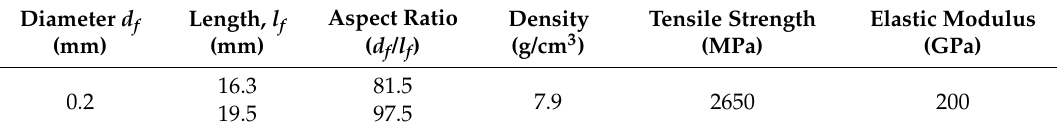
Table 3. Properties of high strength smooth steel